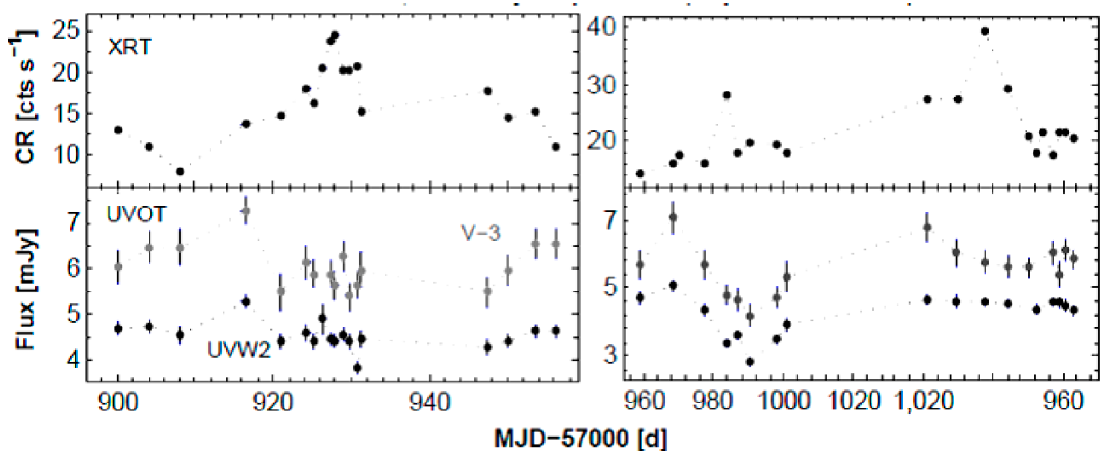
Figure 6. The multiwavelength observations of 1ES 1959+650 performed with Swift-XRT and Ultraviolet-Optical Telescope onboard Swift (Swift-UVOT; reproduced from Reference [28]).